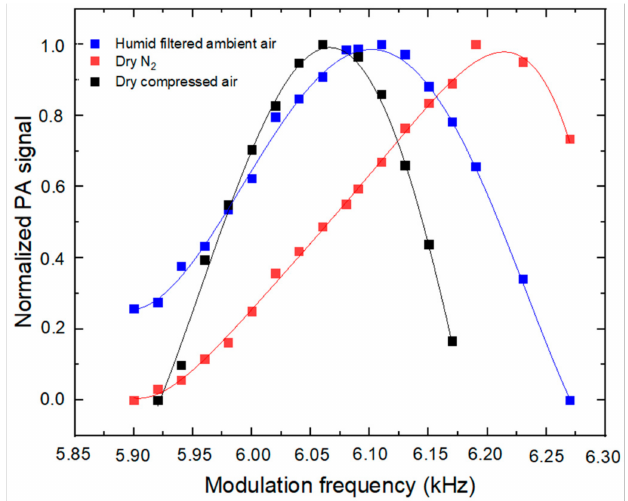
Figure 2. Dependence of the PA signal on the modulation